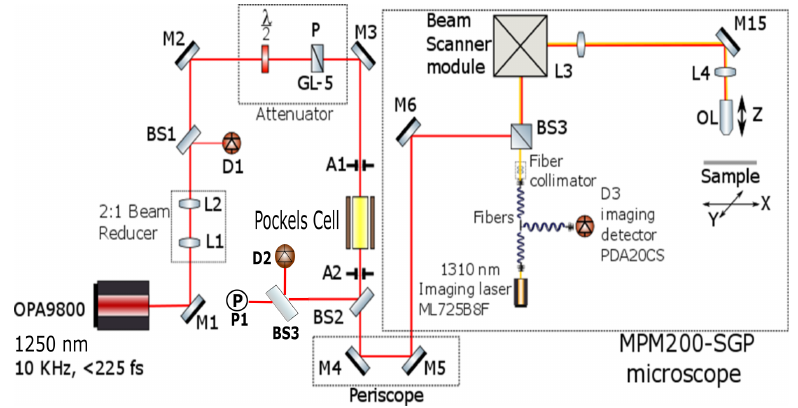
Figure 2. Schematic of setup for SEEs mapping testing after